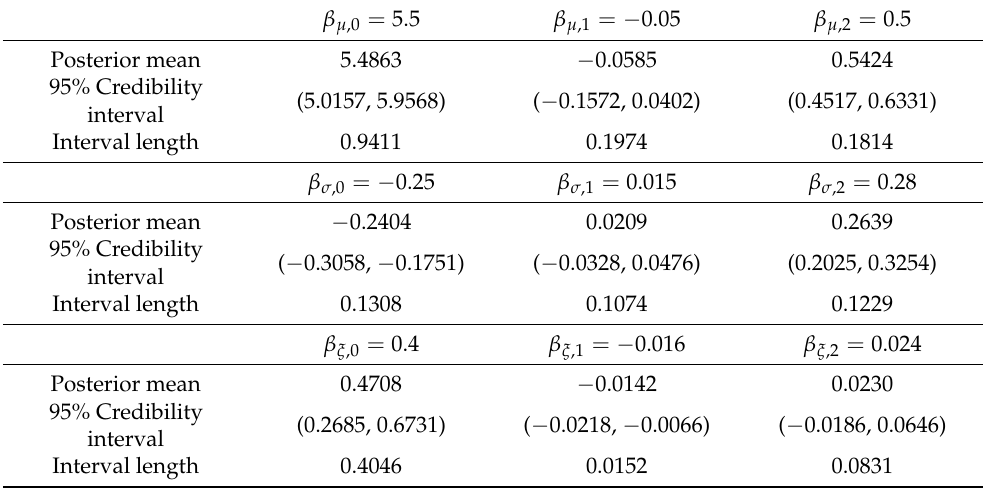
Table 2. Estimates for the regression coefficients of simulations with sample n = 1000 .